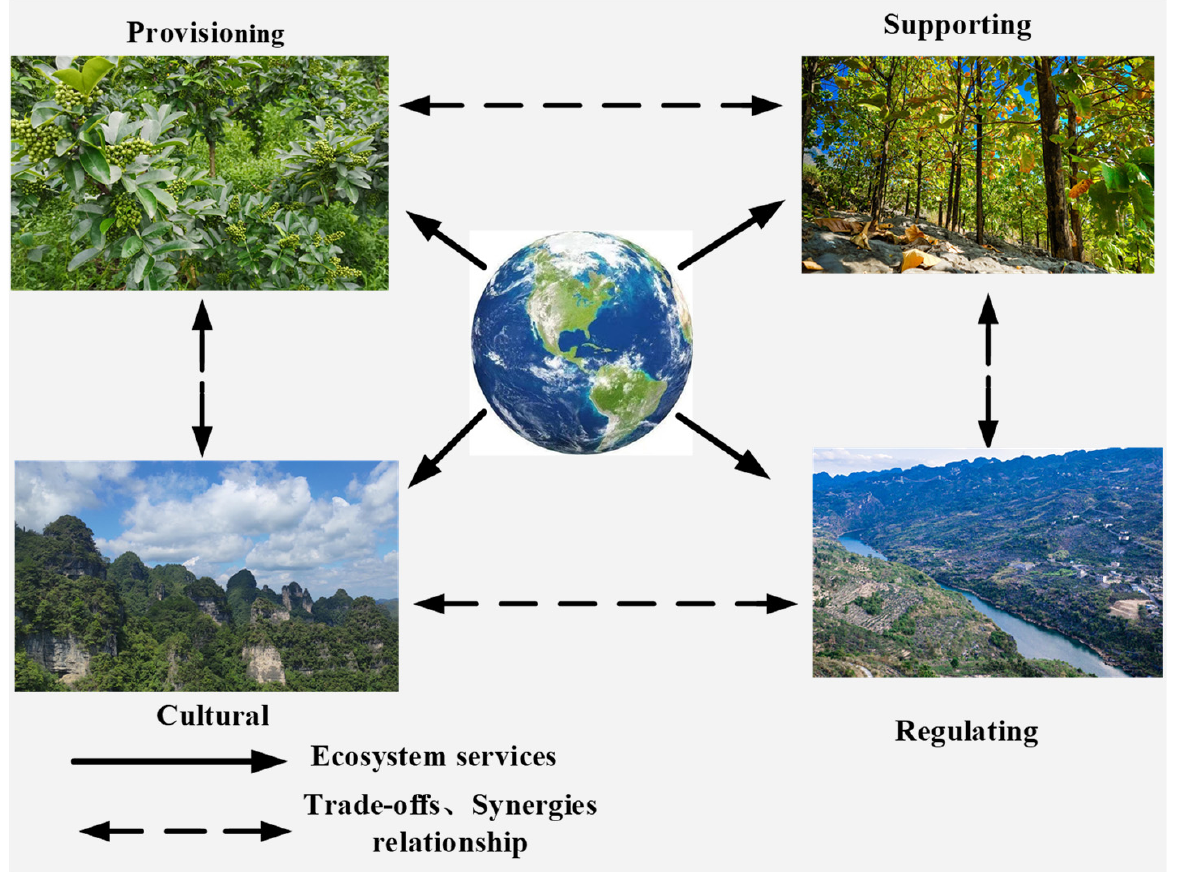
Figure 4. Trade-offs/synergies between forest ecosystem services.